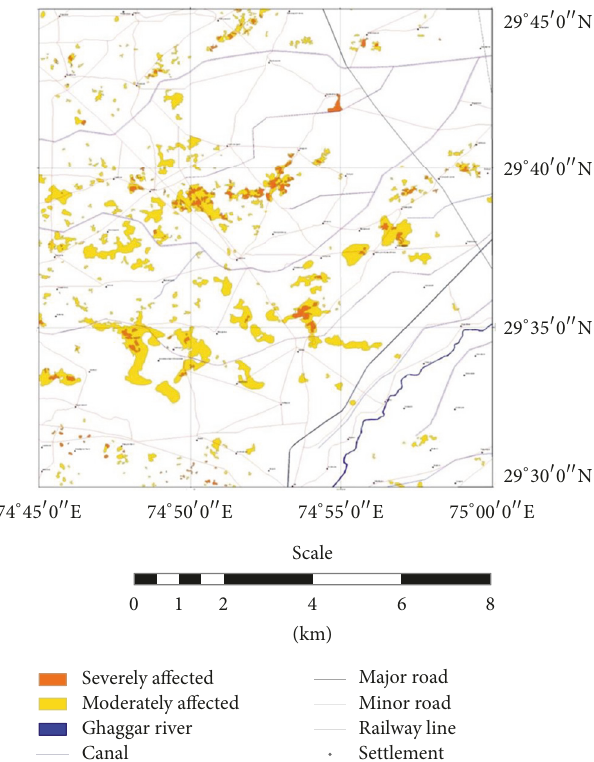
Figure3:MapshowingareaaffectedbyaeoliansandinSirsaDistrict of Haryana,